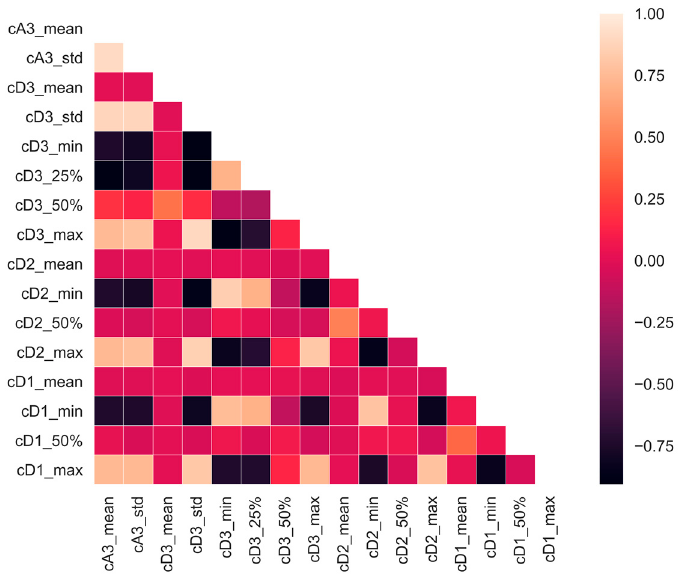
Figure 7. The selected features correlation heatmap after eliminating 12 highly correlated features.